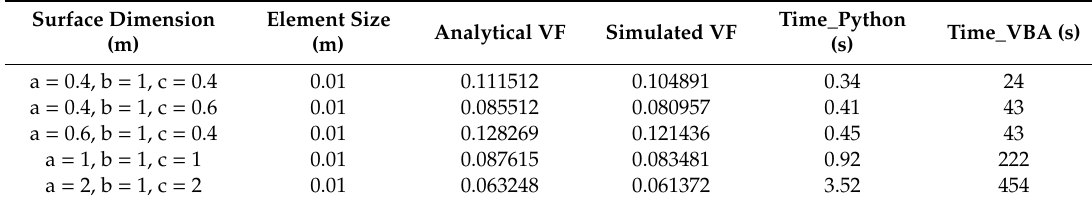
Table 6. Computation time at different surface lengths and heights for Φ = 120⁰ and h i = 0.01 m.